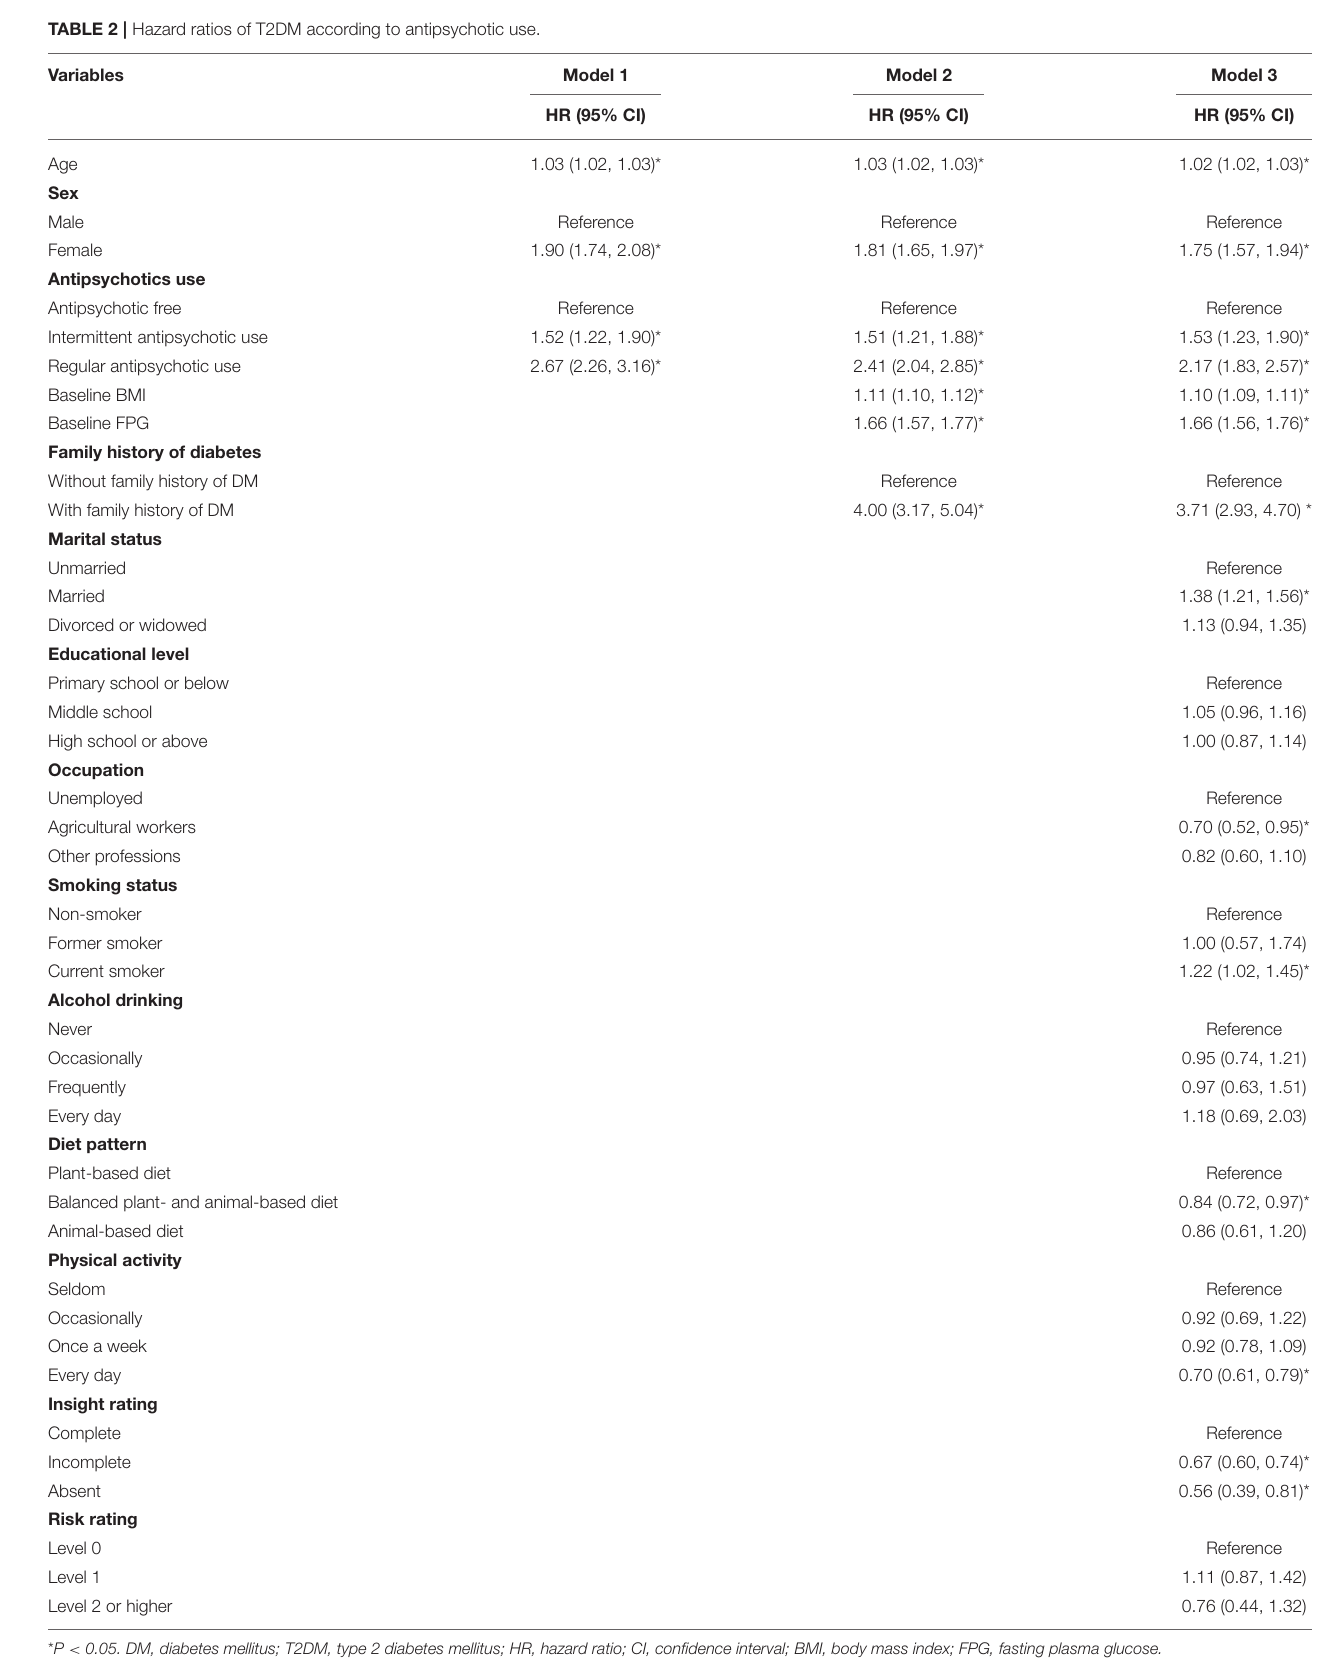
TABLE 2 | Hazard ratios of T2DM according to antipsychotic